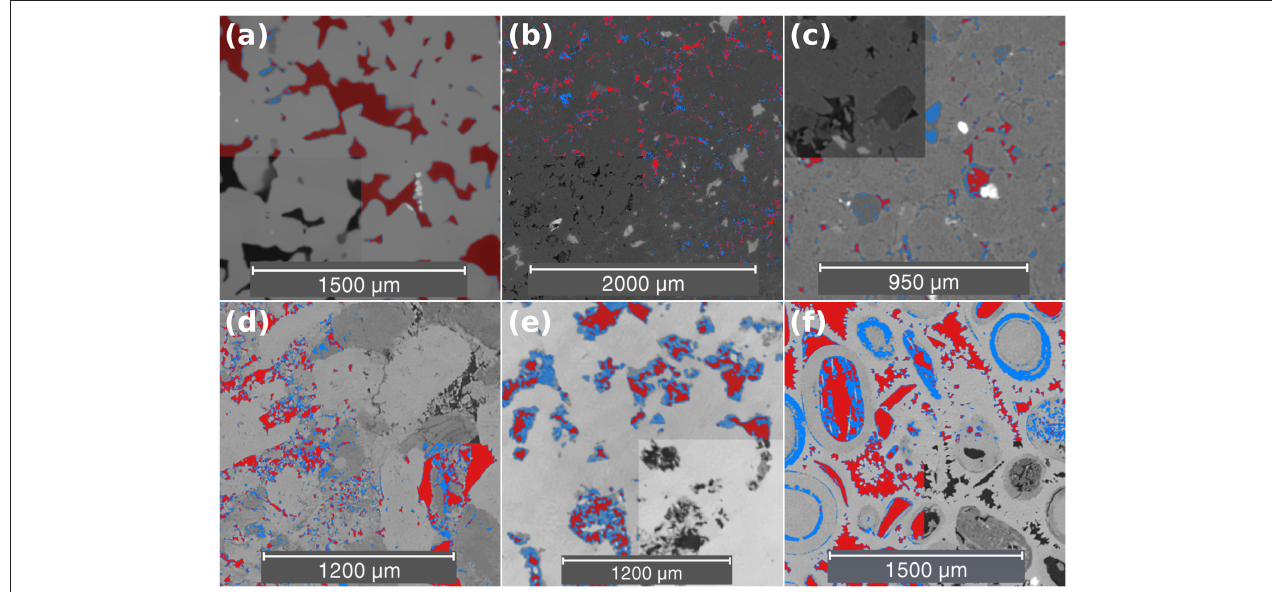
FIGURE 1 | From top, left to right: (a) Doddington sandstone, (b) Knorringfjellet sandstone, (c) Wilcox sandstone, (d) Estaillades limestone, (e) Massangis Jaune limestone, and (f) Savonnières limestone. Single slice view of each sample. A quarter of the image is represented in gray scale only. The remaining voxels display macroporosity in red, and microporosity in